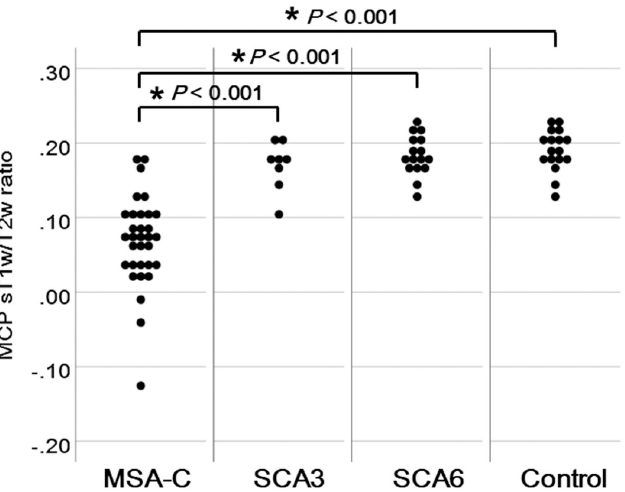
Fig 3. Comparison of the Middle Cerebellar Peduncle (MCP) standardized T1-weighted/T2-weighted (sT1w/T2w) ratio among patients with cerebellar subtype multiple system atrophy (MSA-C), spinocerebellar ataxia type 3 (SCA-3), and spinocerebellar ataxia type 6 (SCA-6) and controls. The MCP sT1w/T2w ratio values were significantly lower in patients with MSA-C than those in patients with SCA-3 and SCA-6 and controls ( � p < 0.001).